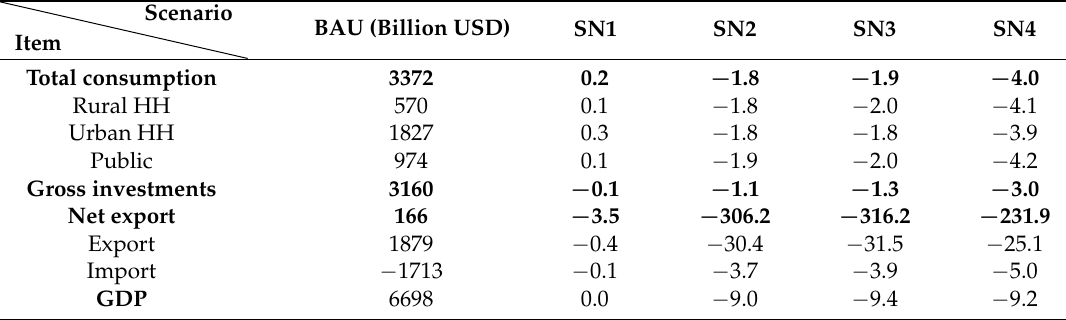
Table 4. GDP and final demand in China in 2050, deviations from BAU.